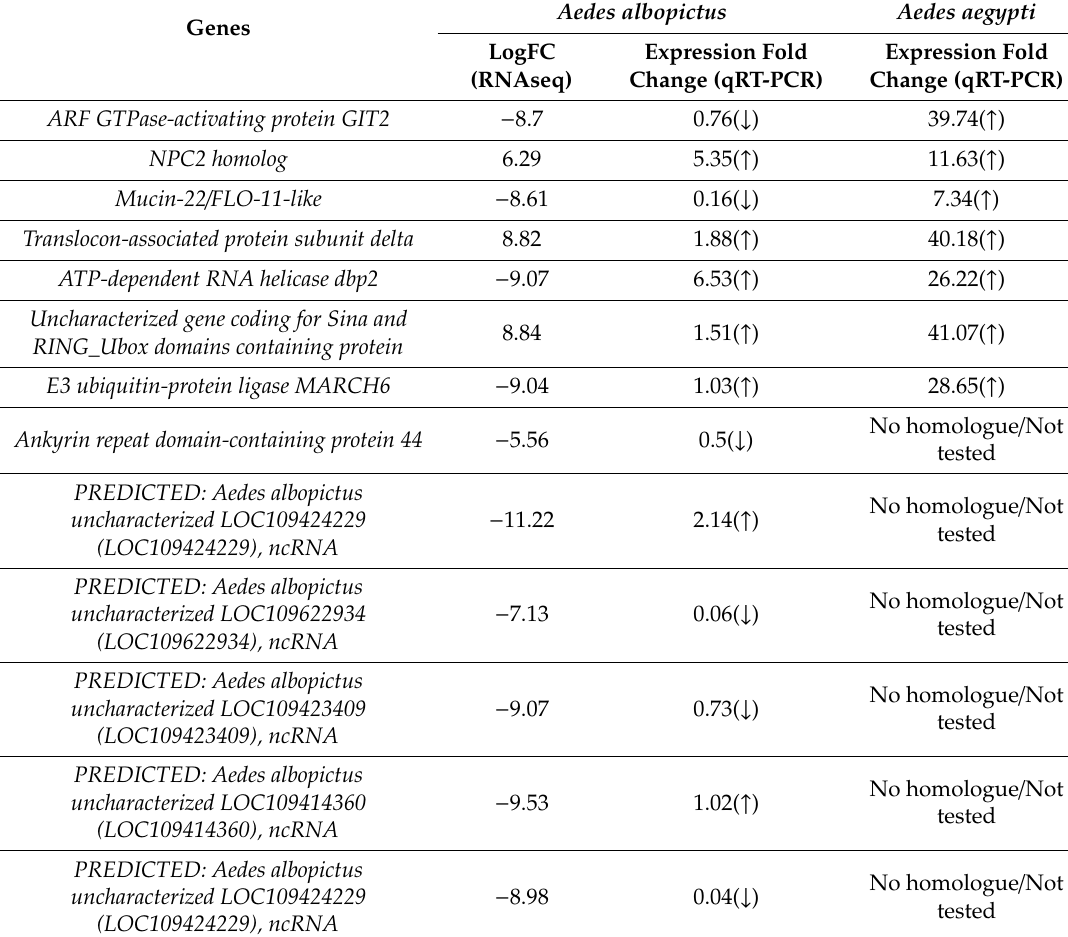
Table 2. List of genes validated by qRT-PCR and comparison of expression fold